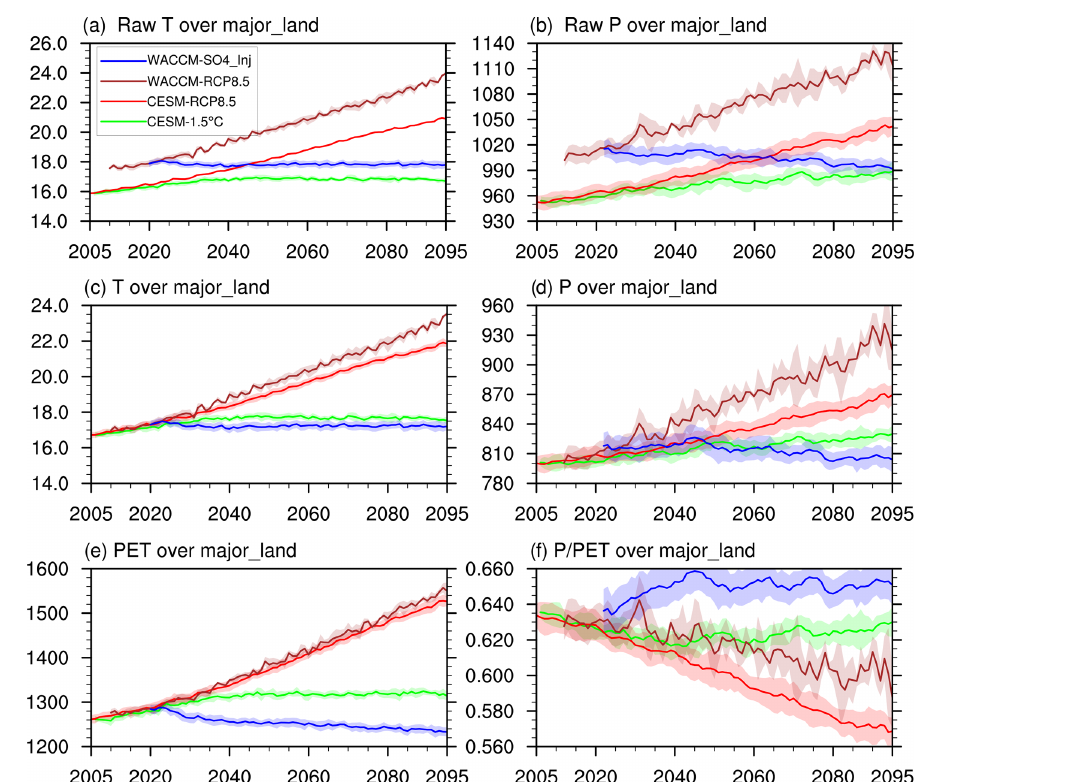
Figure 3. The annual average of major land temperature ( T ) ( ◦ C) ( a, b without bias correction and c, d with bias correction) and major land precipitation ( P ) (mmyr − 1 ) ( a, b without bias correction and c, d with bias correction). Panels (e, f) show the major land PET (mmyr − 1 ) and major land P / PET (unitless) (after bias correction). Shading represents the standard deviation of ensemble members. We have applied decadal smoothing to all the time series, but note that WACCM_RCP8.5 has three ensemble members during 2030–2099 and thus has large fluctuation due to natural variation in contrast with 10 or more ensemble members in other cases.